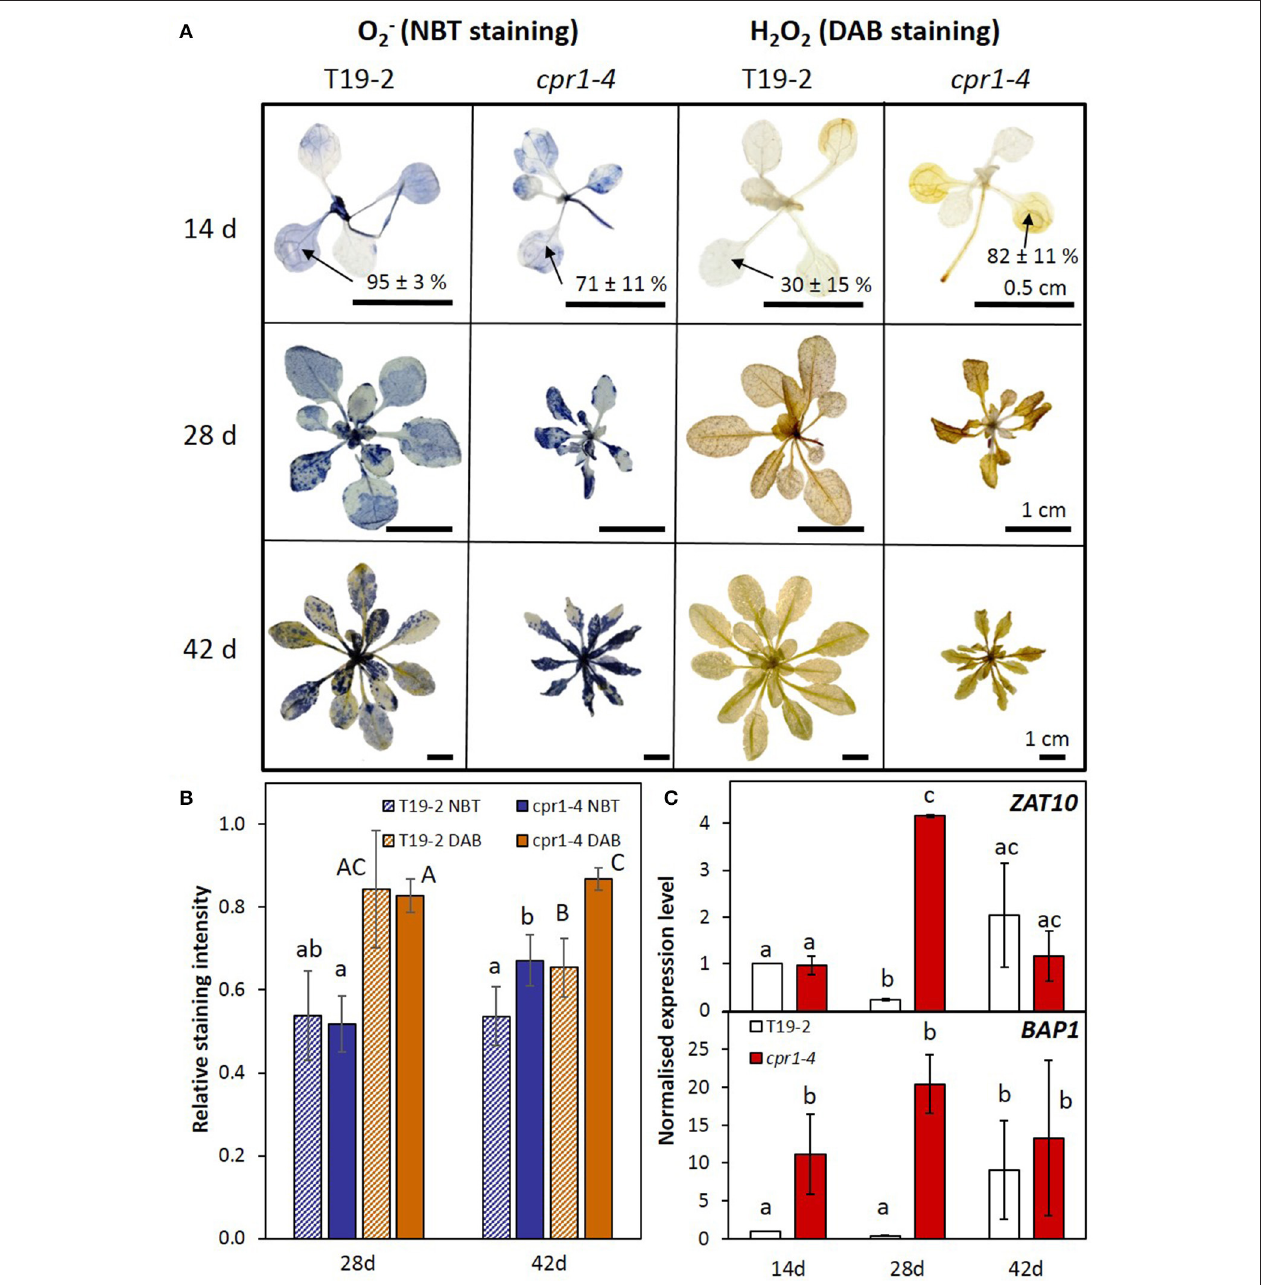
FIGURE 6 | ROS metabolism and signaling in cpr1 mutant and T19-2 plants during development. (A) Detection of O − 2 and H 2 O 2 . Representative pictures from two experiments with five replicates each. For 2-week-old plants, the staining intensity in cotyledons was determined. The percentages (means ± s.d.) show staining intensities in the cotyledons. (B) O − 2 and H 2 O 2 content per rosette area as determined by NBT- and DAB-staining (ANOVA, P < 0.05). (C) Normalized transcript levels of ROS marker genes BAP1 and ZAT10 in cpr1-4 and T19-2 plants during development. Bars represent the mean and standard errors of three biological replicates, each measured in triplicate and normalized to At5g15710 ( F-box ) and At5g08290 ( YLS8 ) transcript levels (Statistically significant differences are labeled with different letters; ANOVA, P < 0.1).